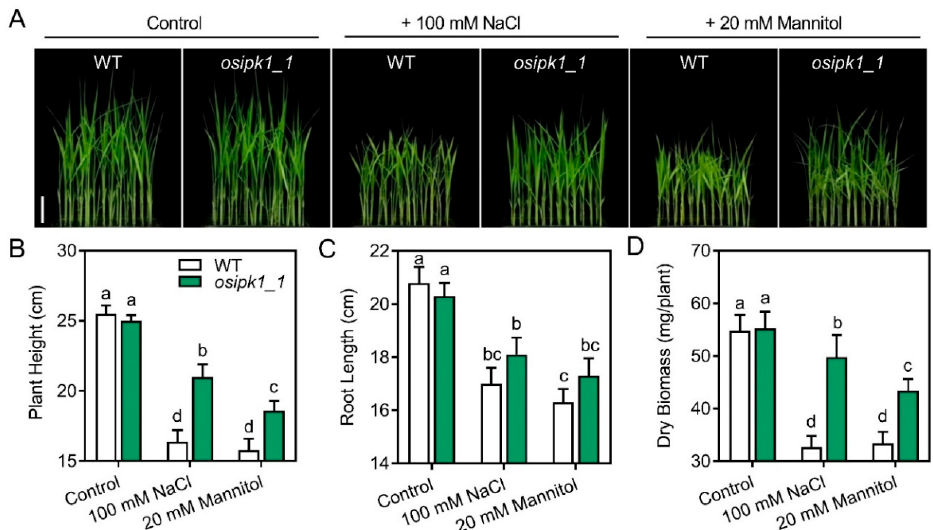
Figure 4. The phenotype of Xidao #1 (WT) and its OsIPK1 mutant line osipk1_1 under salt stress (100 mM NaCl) and drought stress (20 mM mannitol). ( A ) The picture was taken in the 7th day after treatment. Bar = 5 cm. ( B – D ) Six replicates were performed for WT and osipk1_1 . Error bars represent standard error. The different letters (a, b, c, and d) show the significant difference at a probability of p < 0.05.